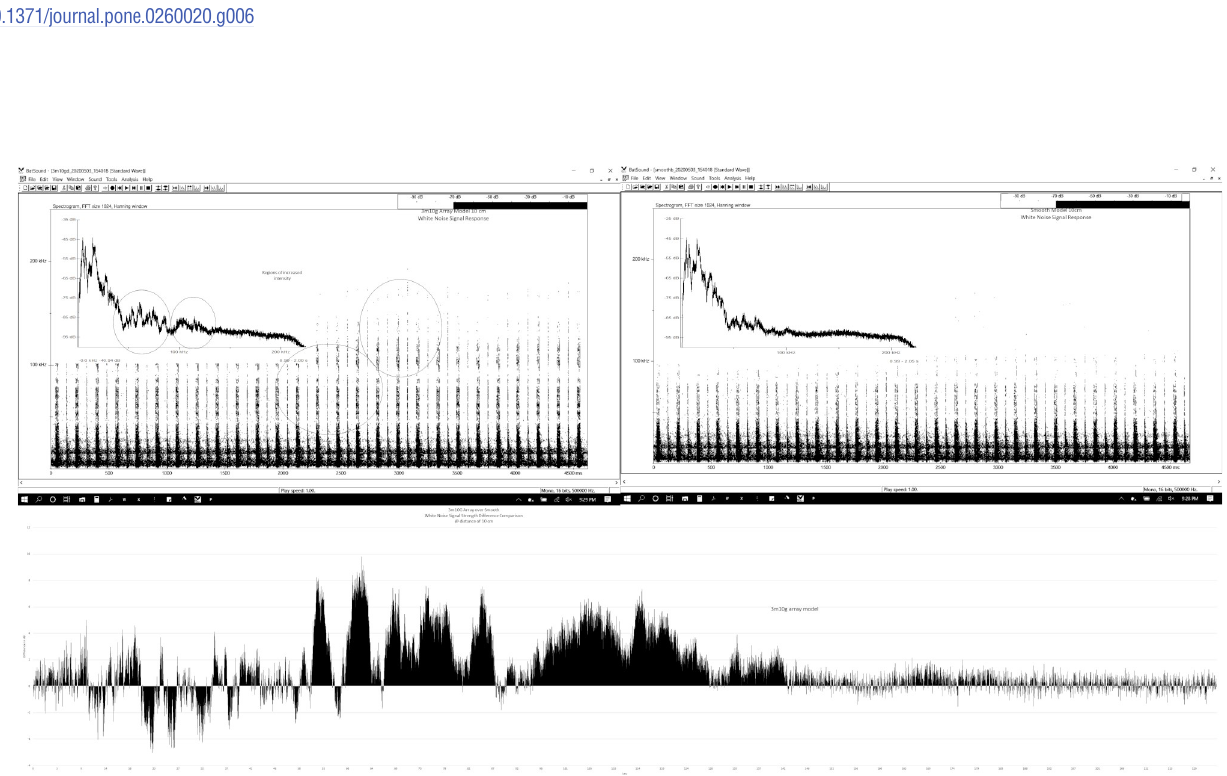
Fig 7. Spectrograms, power spectra and a difference graph comparing the 3mm10G pinna model and the smooth pinna model when exposed to a sound that mimics prey rustling in leaves. Spectrograms and power spectra of the 3mm10G pinna model (A) and the smooth pinna model (B) exposed to manufactured prey sounds at a distance of 20 cm. The circled areas indicate amplitude differences between the models. The frequency difference graph (C) plots the frequency (kHz) differences in amplitude (dB) between the grooved and the smooth model. Amplitudes above the 0 dB line are stronger in the 3mm10g model; amplitudes below the 0 DB line are stronger in the smooth